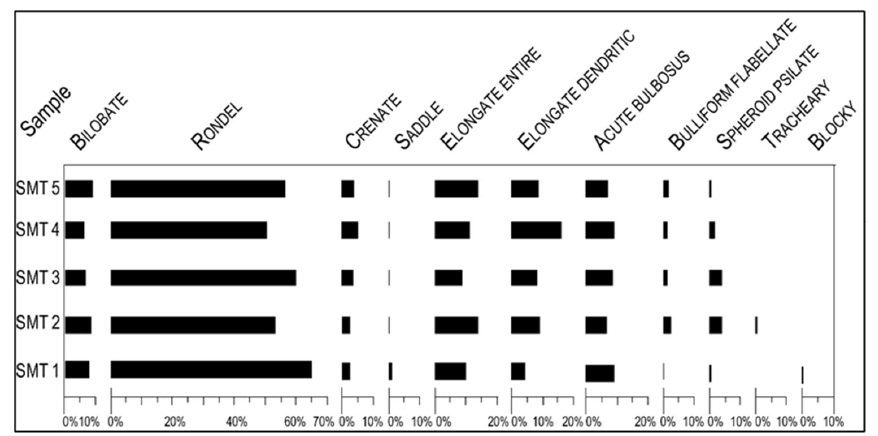
Figure 9. Phytolith diagram from Șoimuş-Teleghi site. Most of the identified morphotypes are attributed to grasses.